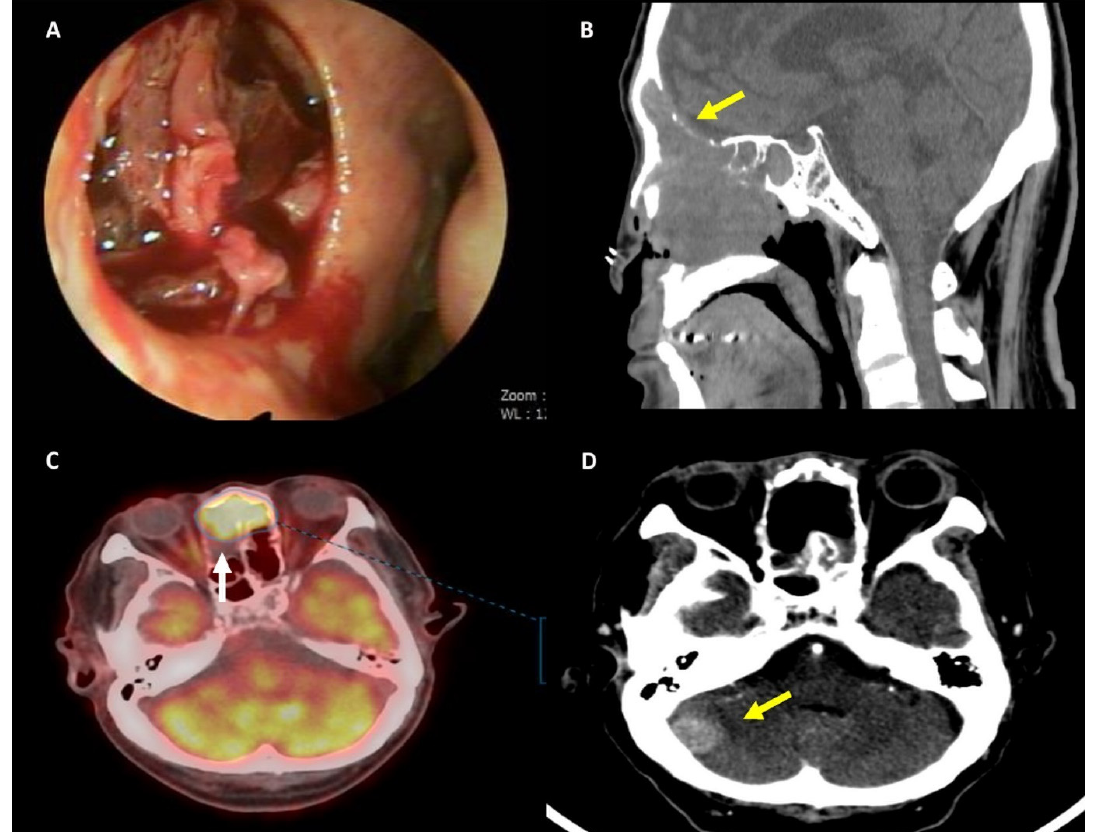
Figure 1. A 65-year-old male was referred to the department of otorhinolaryngology with epistaxis and right nasal obstruction for two months. His medical history revealed diabetes mellitus, hypertension, and pulmonary tuberculosis. ( A ) Physical examination demonstrated an easy-bleeding tumor in the right nasal cavity and bloody crust with an ulcerative lesion at the anterior septum; ( B ) The initial computed tomography (CT) showed a 4.5 cm × 3.4 cm × 4.8 cm soft tissue lesion infiltrating the right ethmoid and maxillary sinuses with destruction at the frontal sinus posterior wall and cribriform plate. Magnetic resonance imaging (MRI) showed a residual mass with destruction in the posterior wall of the frontal sinus, cribriform plate, and dura invasion with suspicious brain parenchyma (right frontal lobe) invasion; ( C , D ) Fluorodeoxyglucose positron emission tomography (FDG-PET) showed a residual hypermetabolic mass involving the superior portion of the nasal cavity and the anterior portion of the ethmoid sinus, with a maximum standardized uptake value (SUVmax) of 8.5. Clinical differential diagnoses included inverted papilloma with malignant transformation, lymphoma, and olfactory neuroblastoma. To confirm the diagnosis, an excisional biopsy was conducted. This case highlights an extremely rare presentation of primary combined SNEC and sarcomatoid carcinoma arising from an inverted papilloma in the sinonasal sinus. To